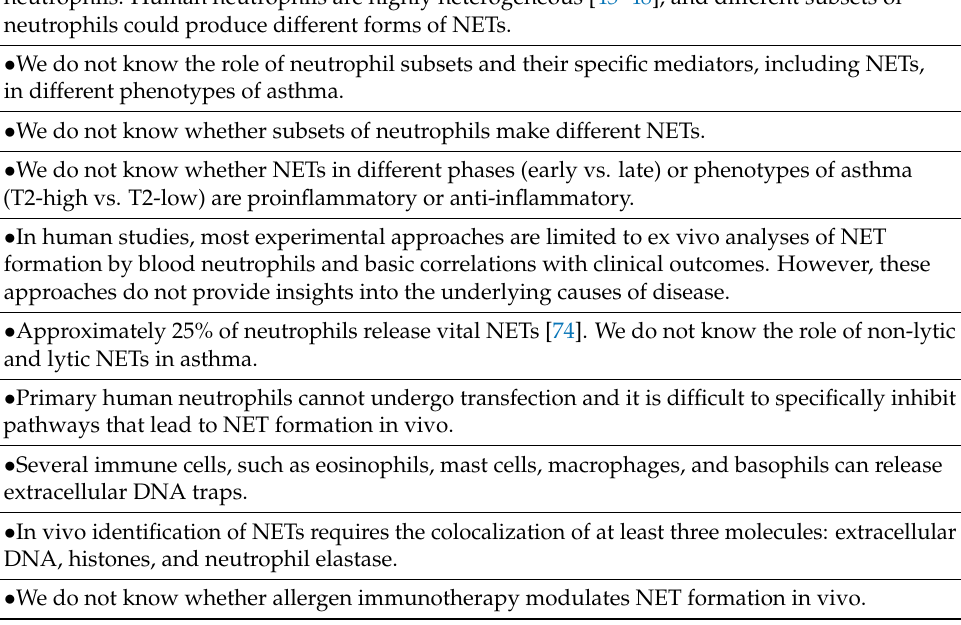
Table 1. Limitations in studying NETs in